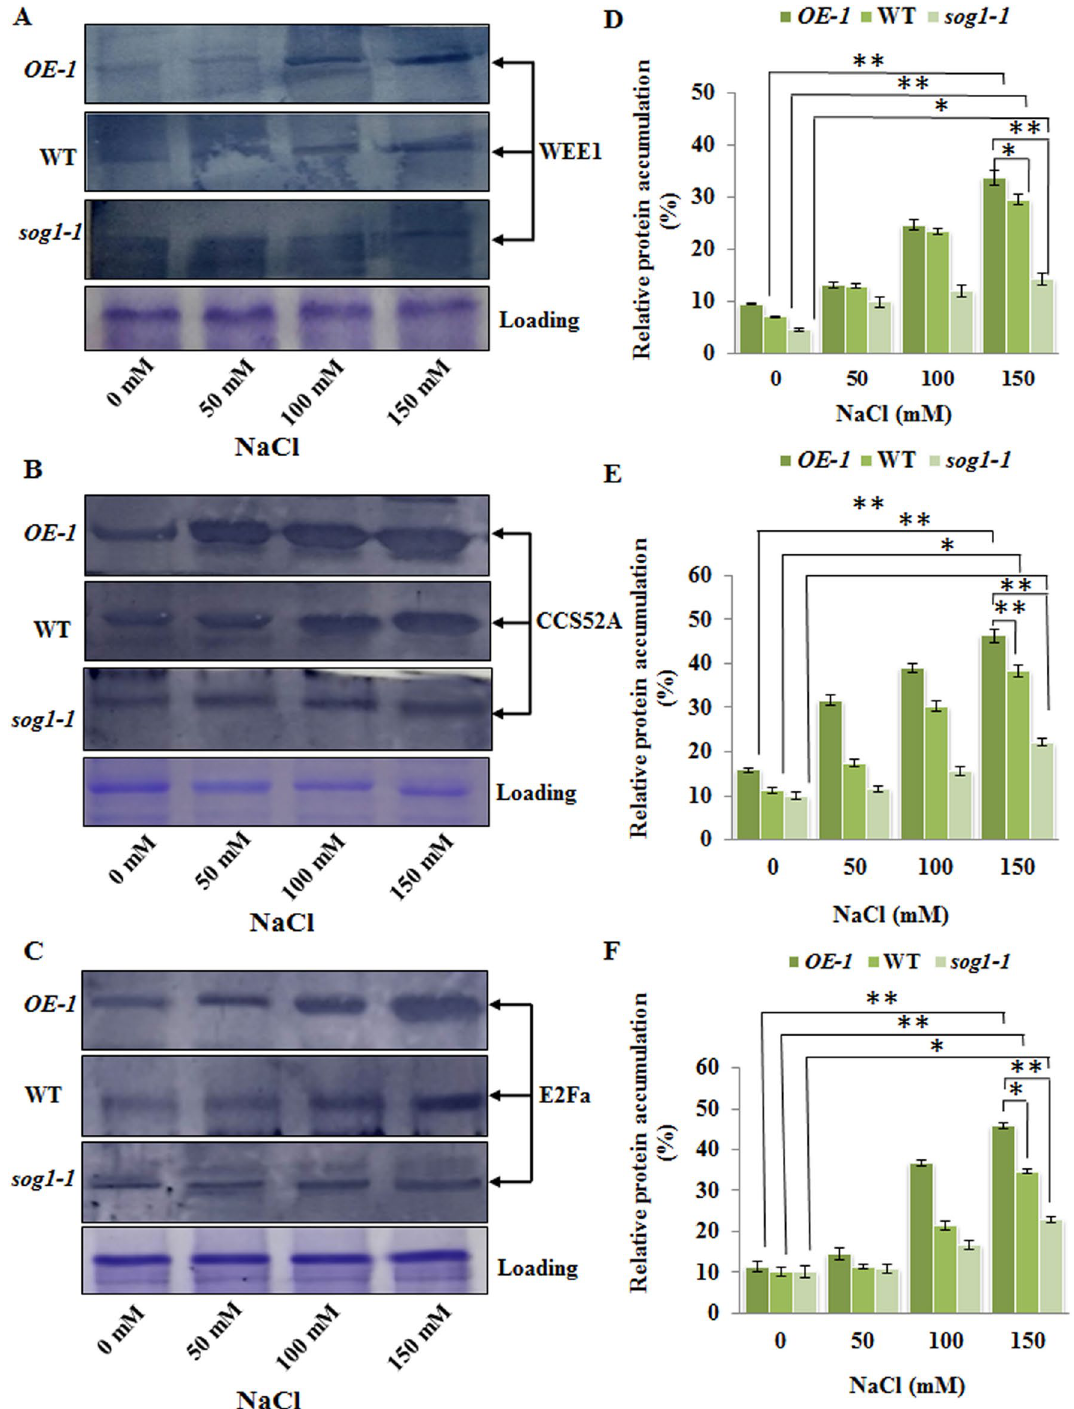
Figure 11. SOG1 is important in controlling cell cycle progression and entry into endocycle in response to salinity stress. ( A – C ) Detection of protein accumulation levels of key regulators of cell cycle progression and endoreduplication including WEE1 ( A ), CCS52A ( B ) and E2Fa ( C ), respectively in 7-days old OE-1, wild- type and sog1-1 seedlings exposed to increasing concentrations of NaCl for 12 h. The blots were cut prior to incubation with the respective primary antibody. Loading control of total protein extracts has been presented in the lowermost panel. Representative gel blot images from at least three independent experiments are shown. Replicates of the protein gel blots have been presented in Supplementary Fig. S16. ( D – F ) Quantification of band intensity for determining the accumulation levels of WEE1 ( D ) CCS52A ( E ), E2Fa ( F ) proteins as detected by immunoblotting. Densitometry analysis was carried out by ImageJ software (NIH). Error bar indicates standard deviation. Asterisks indicate significant statistical differences (* p < 0.05, ** p < 0.01) from control (without NaCl treatment) using one-way ANOVA factorial